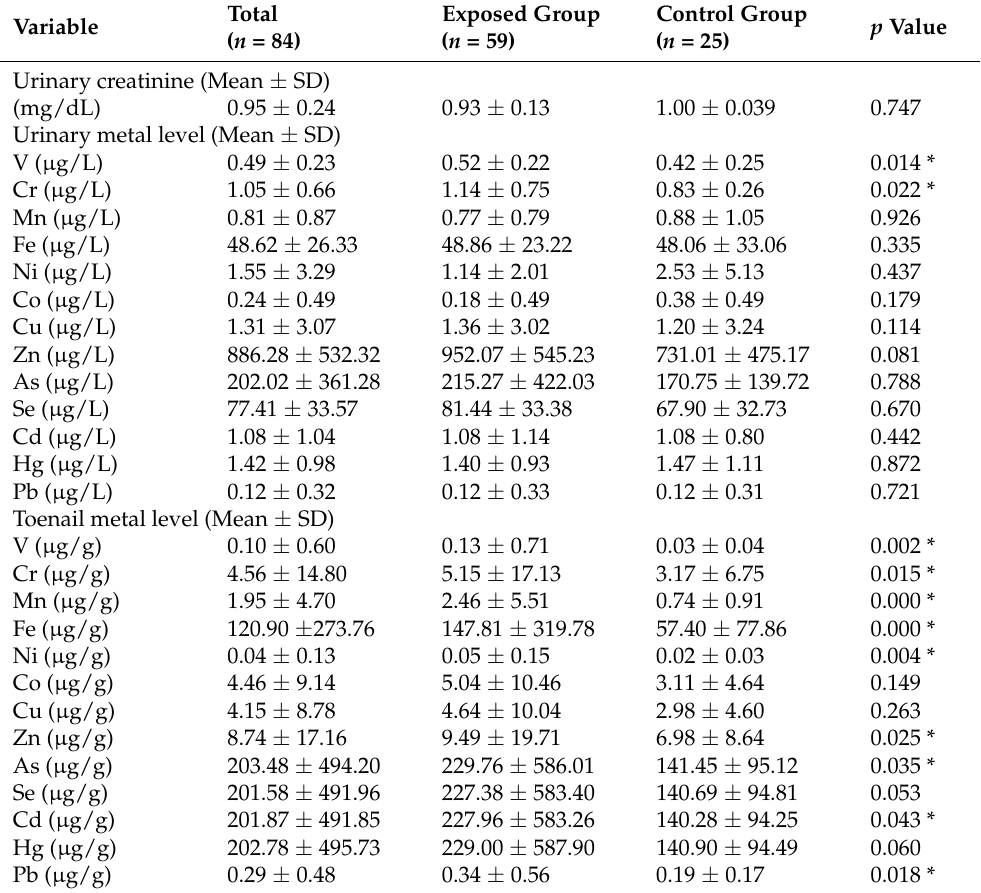
Table 2. Comparison of the metal biomarker concentrations between the exposed and control groups.